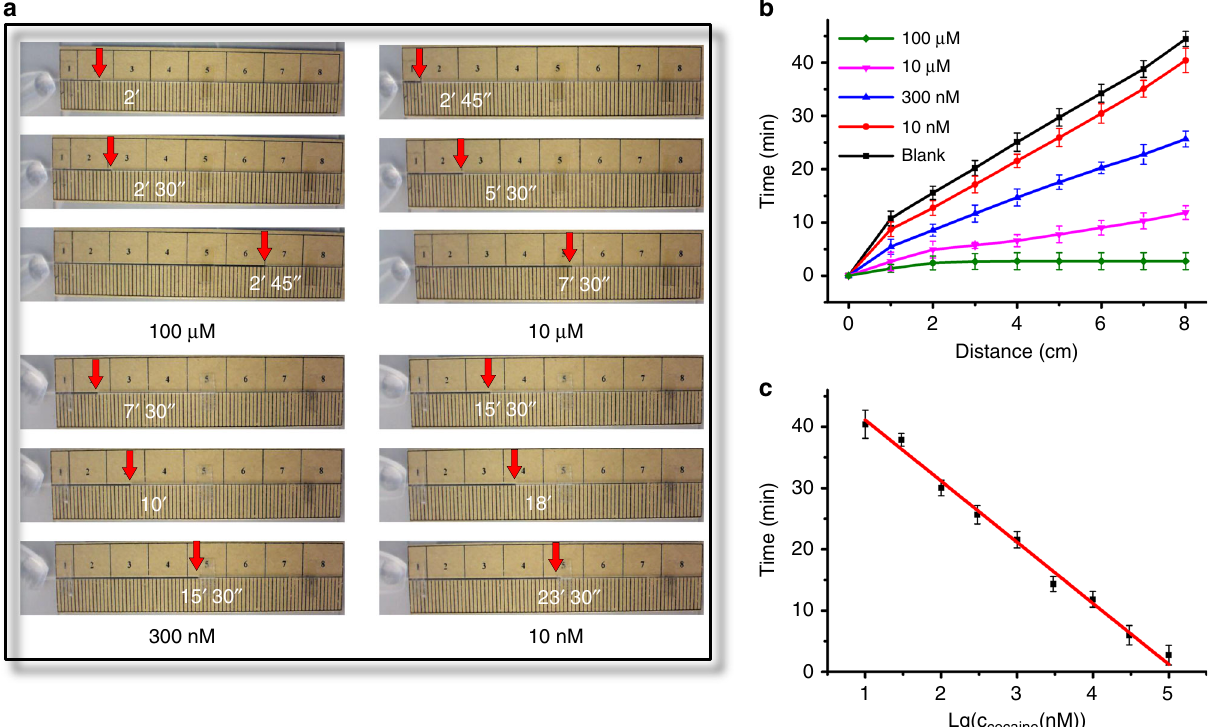
Fig. 5 Performance of the CSDR-Sensor for the detection of cocaine. a Images showing sample solution advancement for the detection of cocaine at different time. b Time-dependent sample solution advancement with different concentrations of cocaine. c Timing results for the detection of various concentrations of cocaine. Each data point is an average of three replicates ( N = 3), and the error bars indicate the standard